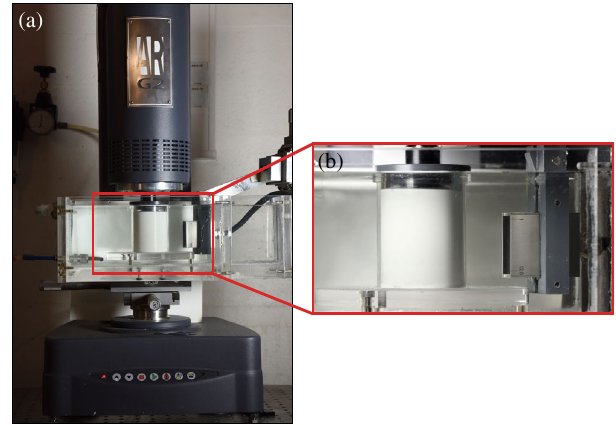
FIG. 10. Picture of the experimental arrangement. (a) Global view of the setup showing the rheometer with the large water tank surrounding the Taylor-Couette cell and used both for thermo- statation and for acoustic impedance matching between the cell and the ultrasonic probe. (b) Enlargement showing the ultrasonic probe (on the right) facing the Taylor-Couette geometry filled with the cornstarch suspension and closed by a lid (in gray) to minimize